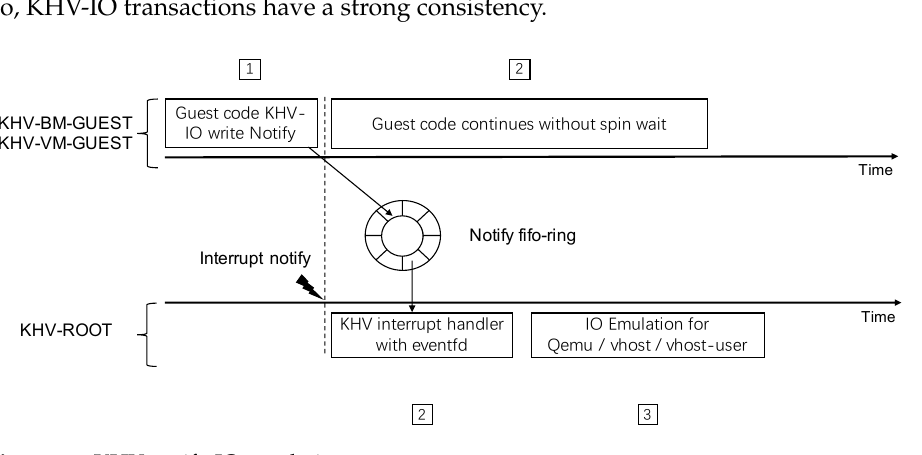
Figure 12. KHV notify IO emulation